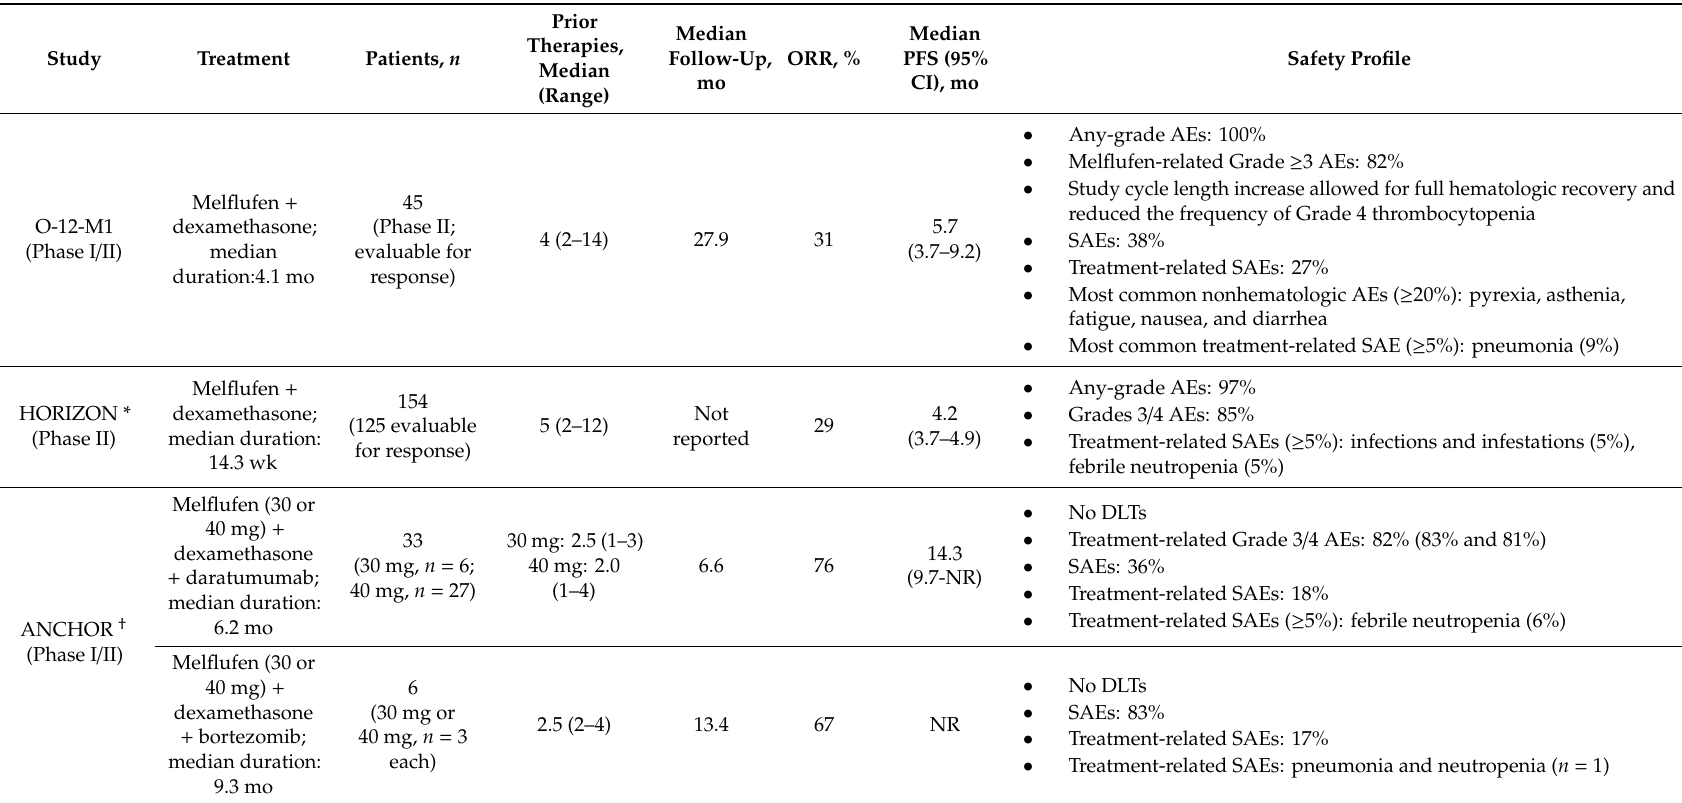
Table 3. E ffi cacy of melflufen combination therapies in patients with multi-refractory multiple myeloma